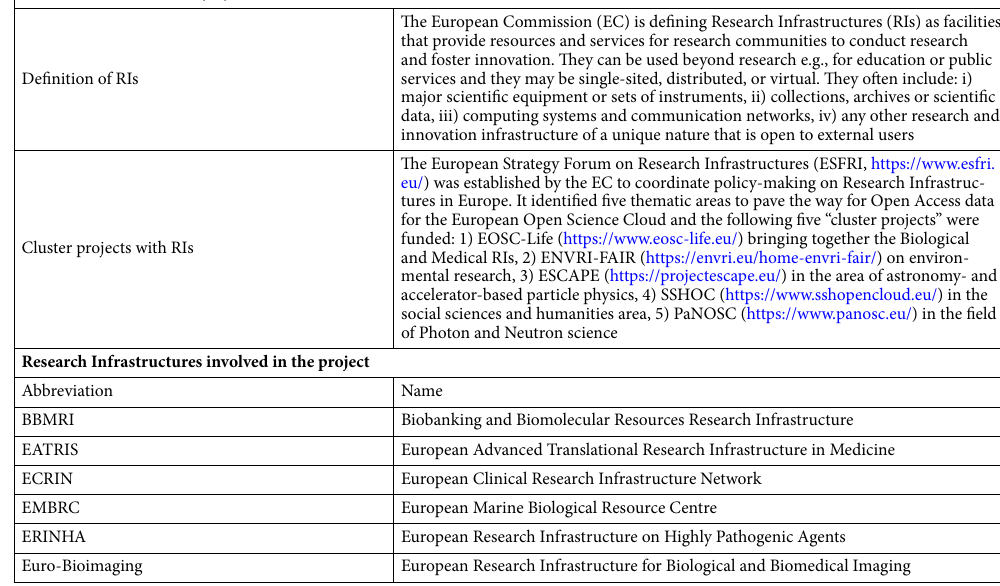
Table 1. Involved Research Infrastructures from the Life Sciences and definition of research infrastructures and cluster